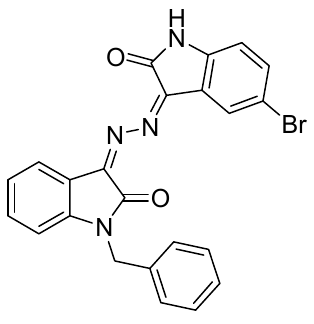
Figure 2. Chemical structure of the title compound 3 .